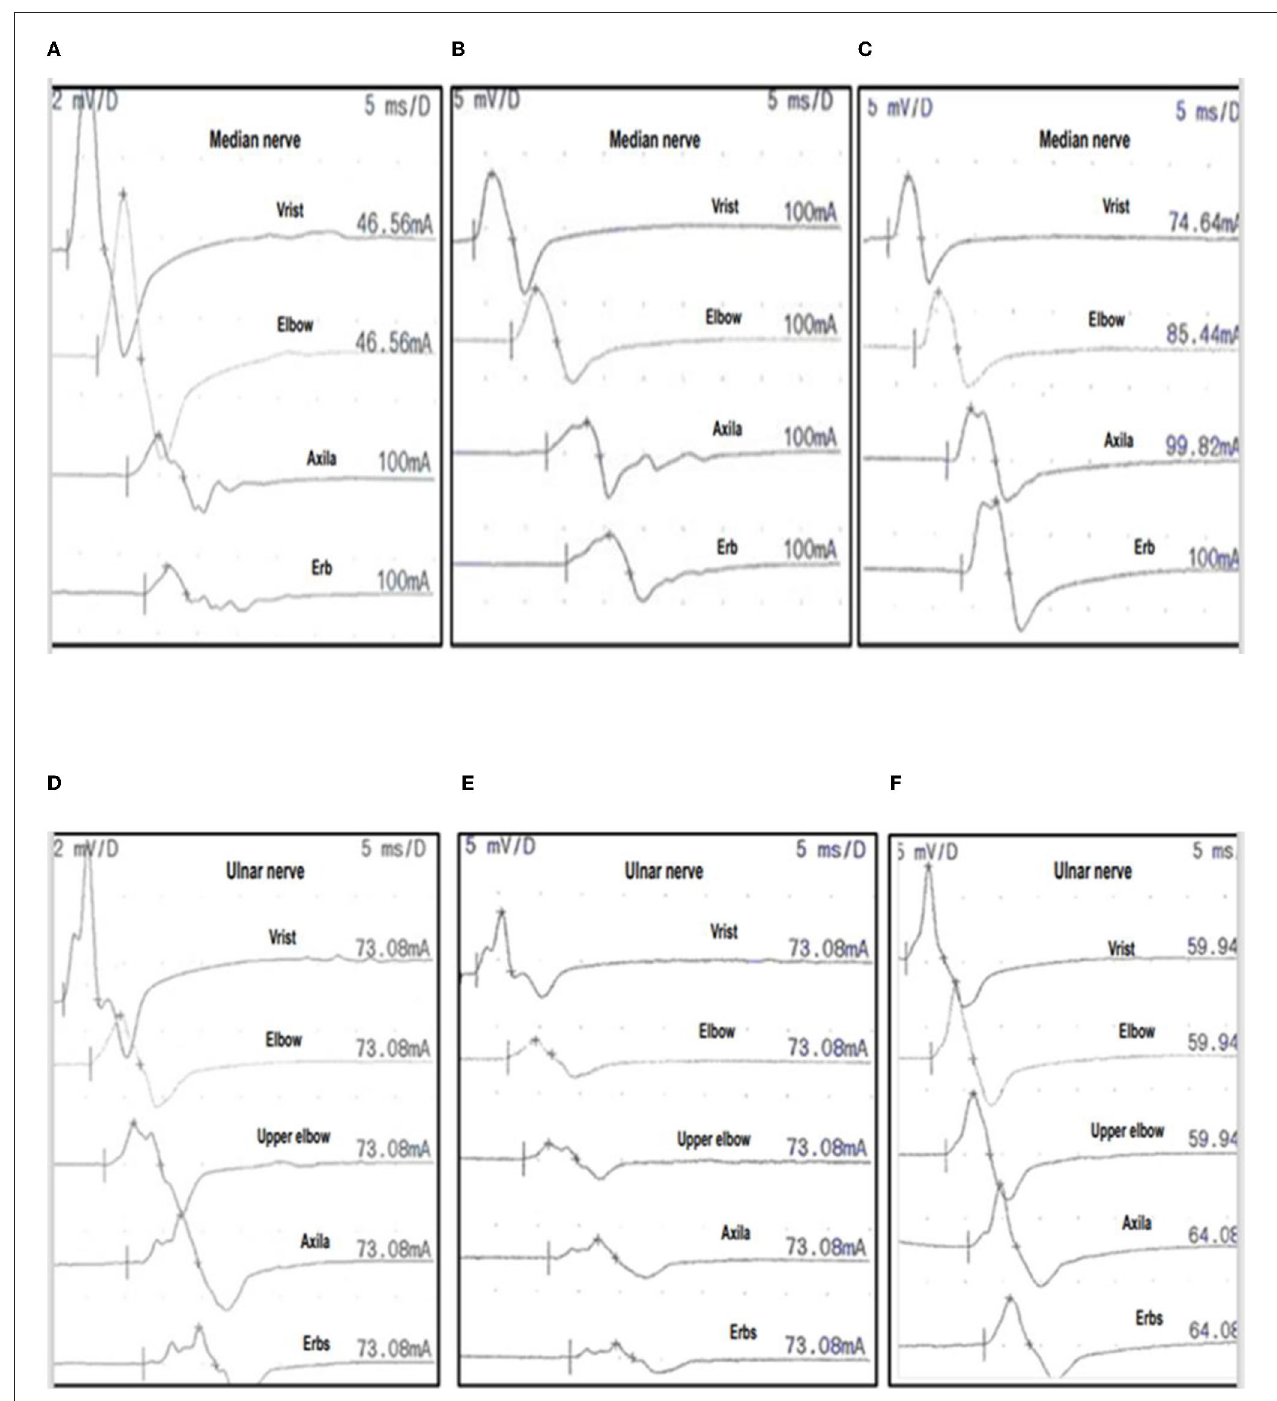
FIGURE 1 | Serial nerve conduction studies (NCS) of case 1. Three serial NCS of the median nerve (A–C) and ulnar nerve (D–F) in case 1, performed at 1 week, 3 weeks, and 1 month after onset (see Tables 2 , 3 for nerve conduction values). Median nerve: 1st week (A) , 3rd week (B) , 4th at 1 month (C) with CMAP recorded after stimulation from distal to proximal, with stimulation at wrist elbow, axilla and Erb’s point, to APB muscle. Ulnar nerve: 1st week (D) , 3rd week (E) , 4th at 1 month (F) with CMAP recorded after distal to proximal stimulation at wrist, below elbow, above elbow, axilla and Erb’s point, to ADM muscle. In the 1st and 3rd week the median and ulnar nerves show CBs or amplitude ratio pCMAP/dCMAP < 0.7, and duration ratio pCMAP/dCMAP < 130%. DML and MCV are preserved ( Table 3 ). At 1 month, RCF (amplitude ratio pCMAP/dCMAP < 0.7 on the first test) improves more than 0.2 in the median and ulnar nerve. Consequently, these changes are indicative of RCF. APB, abductor pollicis brevis; ADM, abductor digiti minimi; BCs: motor conduction blocks; CMAP, compound motor action potential; pCMAP, proximal CMAP; dCMAP, distal CMAP; DML, distal motor latency; VCM, motor conduction velocity.